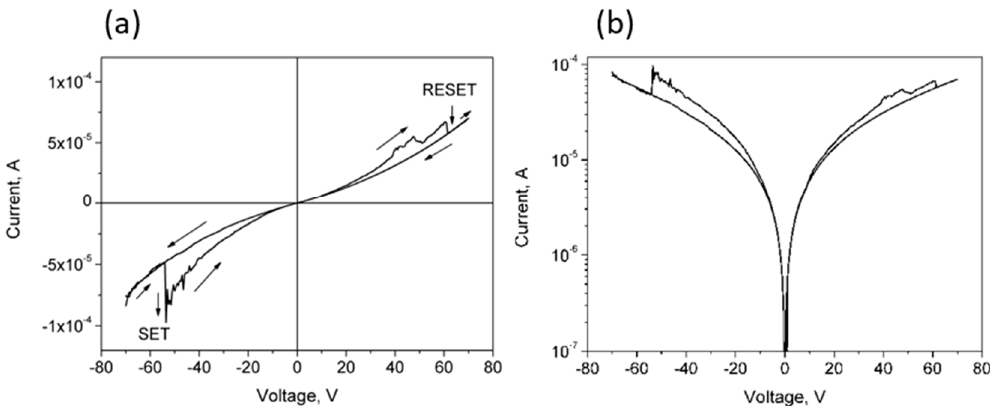
Figure 6. ( a ) Linear and ( b ) semilog IV curves for CNP-TiO 2 film in the voltage range [ − 70 V, 70 V]. The arrows in the plot in ( a ) indicate the sequence of the current values measured in the forward and reverse voltage sweeps.